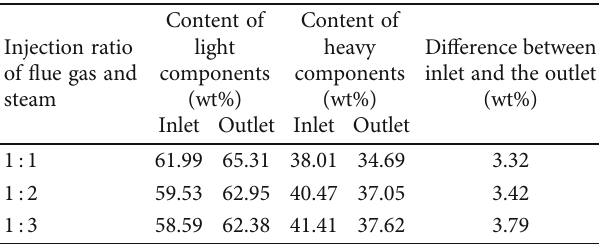
Table 3: Comparison of the content of heavy and light components at the inlet and outlet. Injection